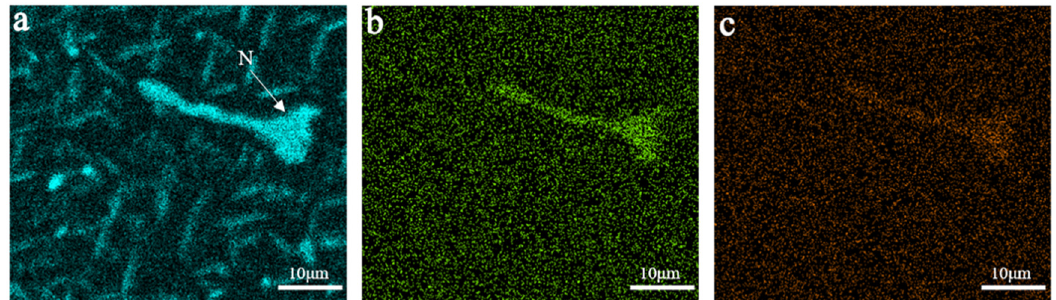
Figure 4. Elemental mapping of the alloy homogenized at 500 °C for 8 h: ( a ) Cu (Cu-rich precipitates arrowed by L and M), ( b ) Ce, and ( c ) La elements.